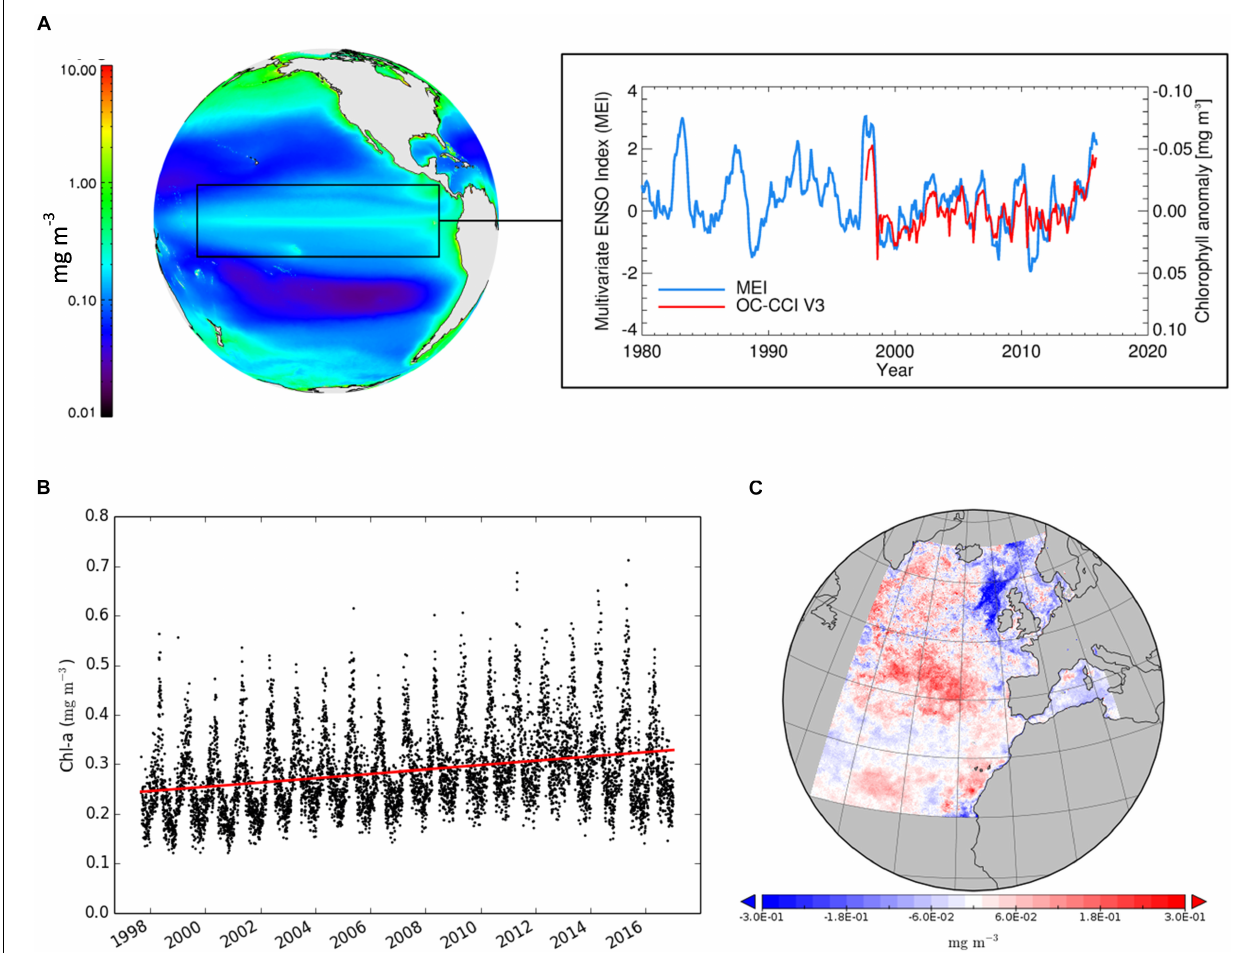
FIGURE 4 | (A) Relationship between chl-a and the ENSO climate mode: note that the scale of chl-a anomalies is inverted. chl-a image is from an annual climatology. The monthly multivariate ENSO Index (MEI) was downloaded from the NOAA website (http://www.esrl.noaa.gov/); monthly plotted chlorophyll data were taken from the OC-CCI/CMEMS data set (modified from von Schuckmann et al., 2016); CMEMS north-east Atlantic region: (B) Time series (1997–2016) plot; (C) anomaly map for 2016 (with respect to 1997–2014 reference period) (re-worked from von Schuckmann et al.,